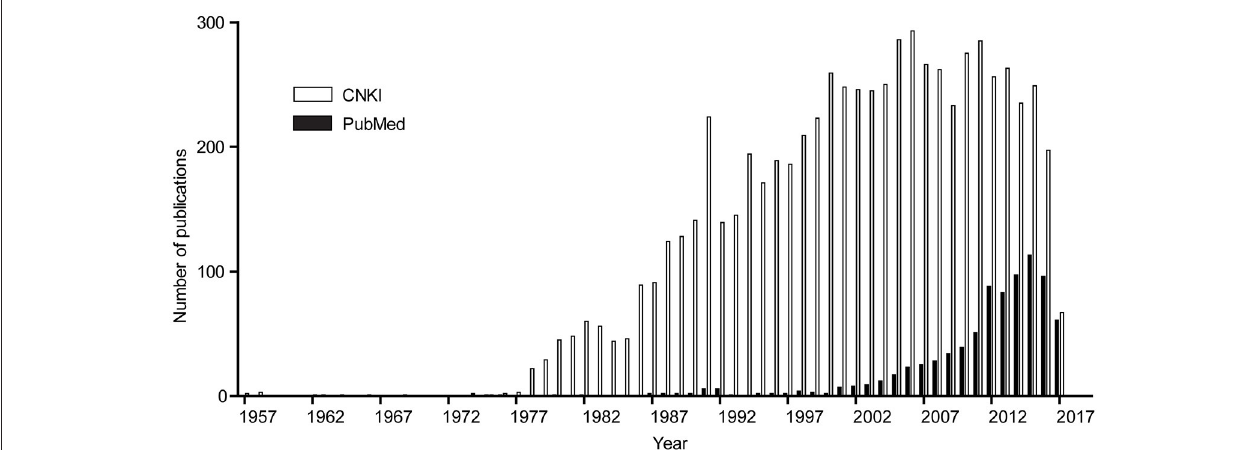
FIGURE 1 | Number of papers published by scientists in China each year since 1957. The key word “ Toxoplasma ” and affiliation “China” were used to search the PubMed database (https://www.ncbi.nlm.nih.gov/pubmed/) for papers published by scientists in China in international journals. The keywords “ Toxoplasma ” or “toxoplasmosis” or the Chinese equivalent of the two were used to search the Chinese library CNKI (http://www.cnki.net/) to estimate the papers in Chinese journals. Subsequently the numbers of papers from the two searches were reported by year.